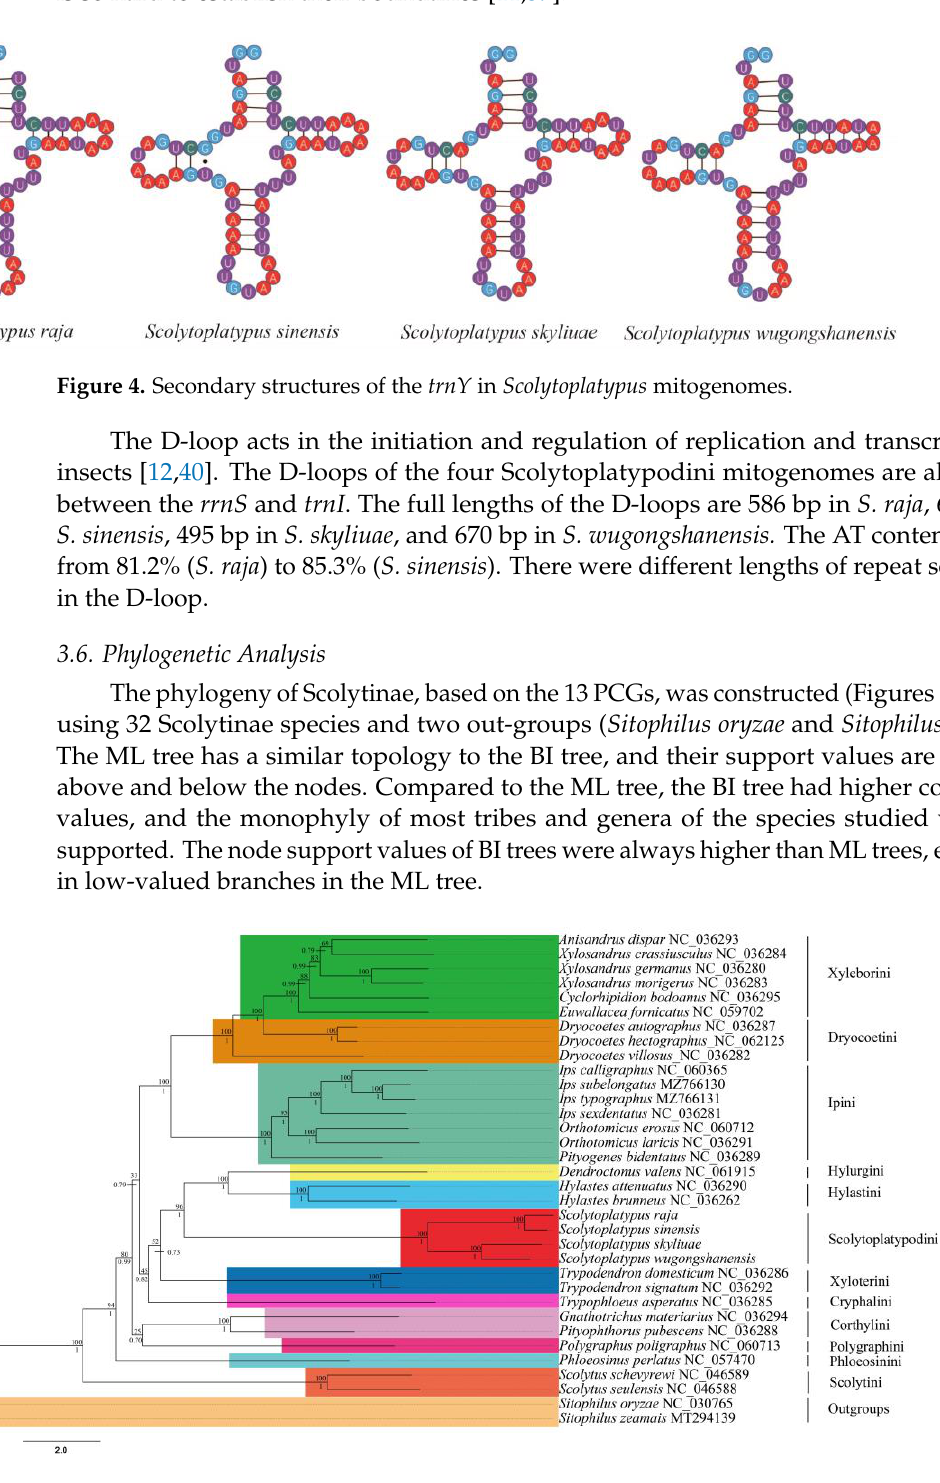
Figure 5. Phylogenetic tree of Scolytinae inferred from ML and BI methods based on 13 PCGs. The ML tree has the same topology as the BI tree, and their support values are reported above and below the nodes, respectively.